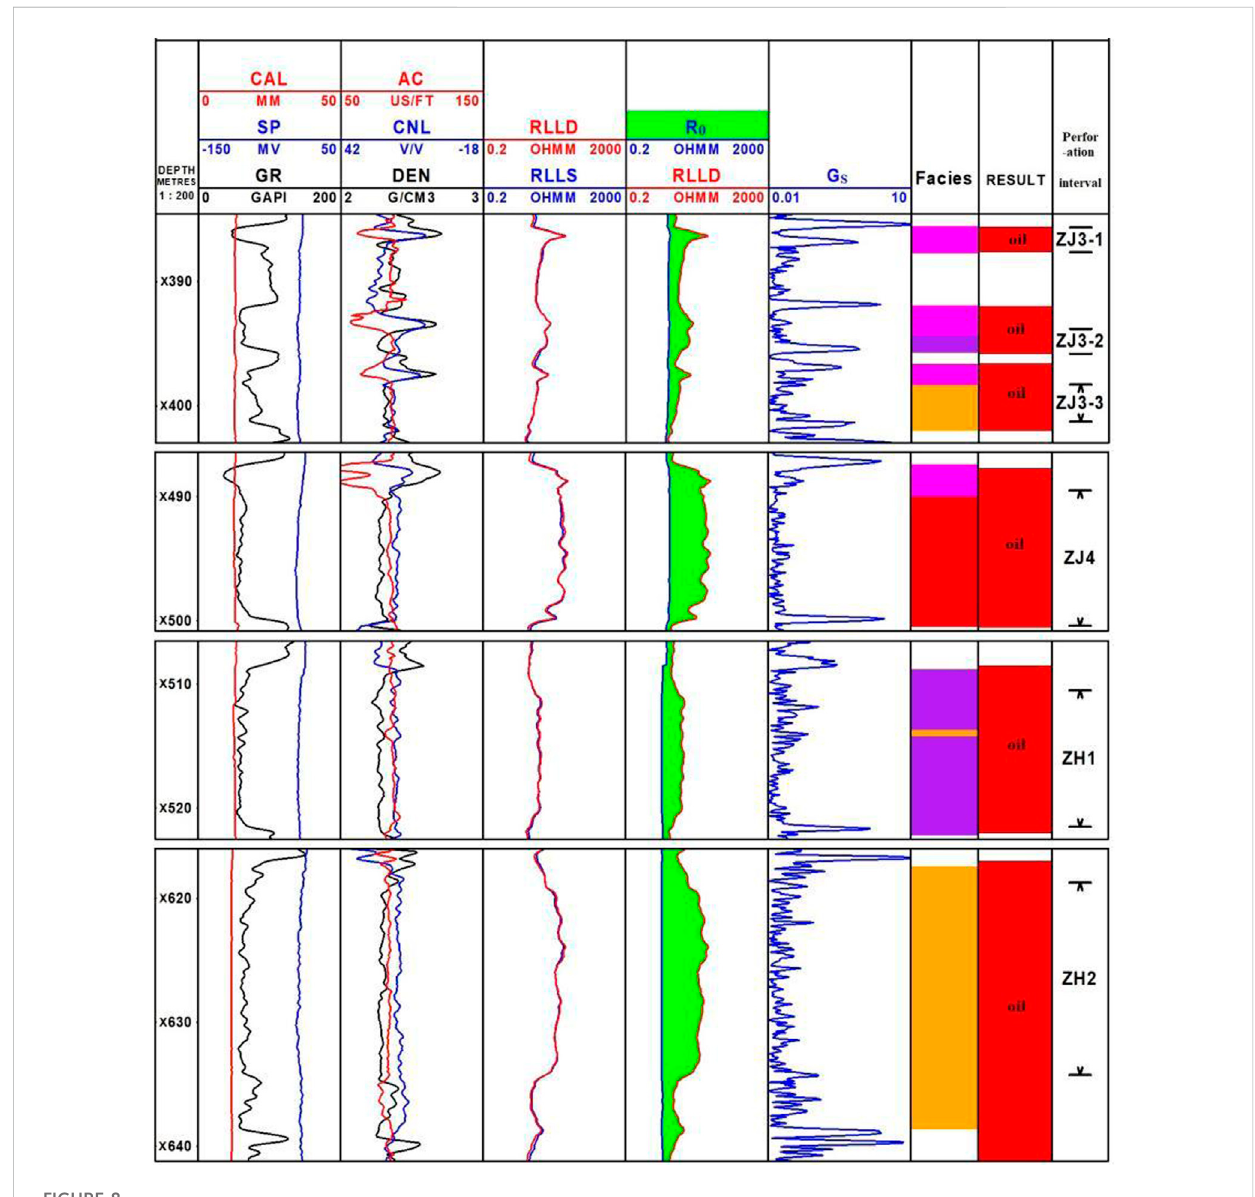
FIGURE 8 Figure of logging facies delineation results of well